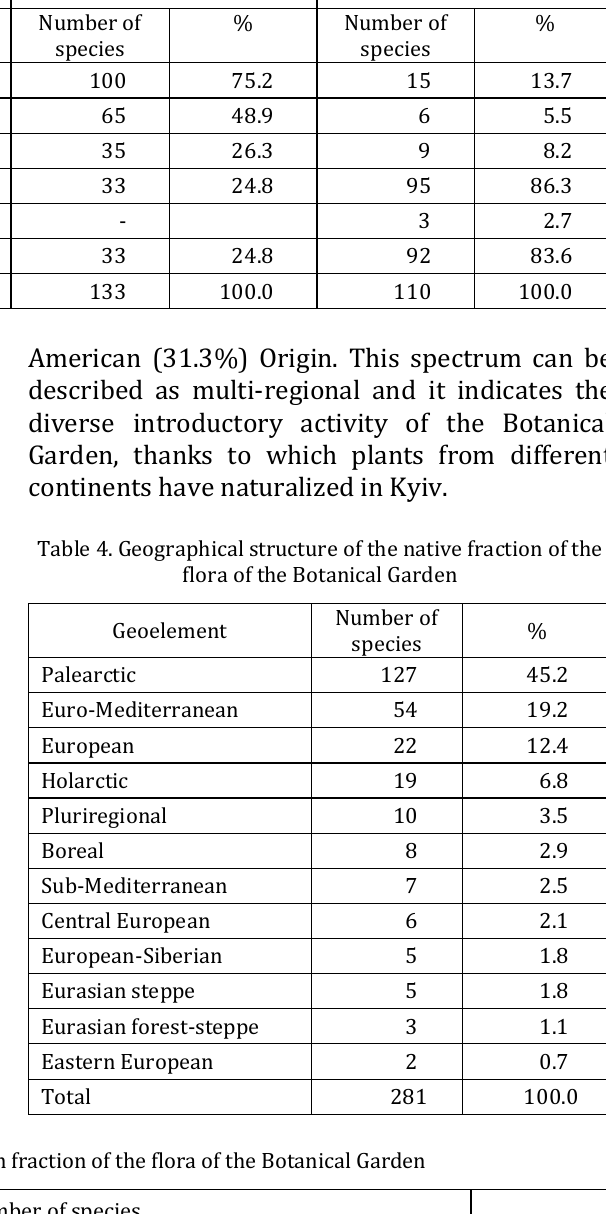
Table 3. Immigration structure of the alien fraction of the flora of the Botanical Garden The whole fraction Category